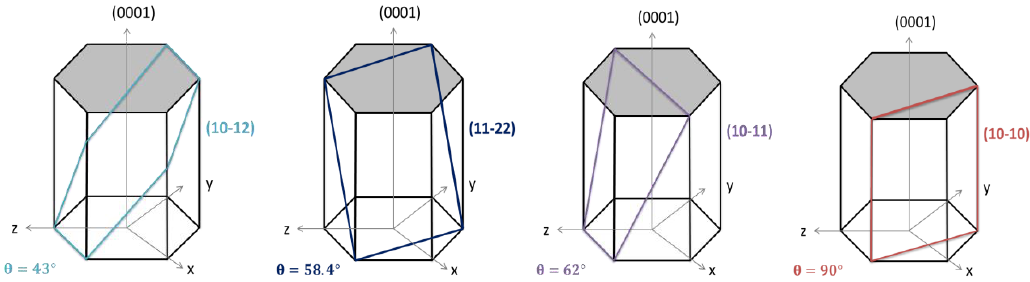
Figure 2. Schematic representation of semipolar (101 ̅ 2), (112 ̅ 2), (101 ̅ 1) and non-polar (101 ̅ 0) orientations for WZ InGaN. The shaded area marks polar (0001) orientation. Crystal angle θ is defined as the angle between growth-axis and the c-axis.